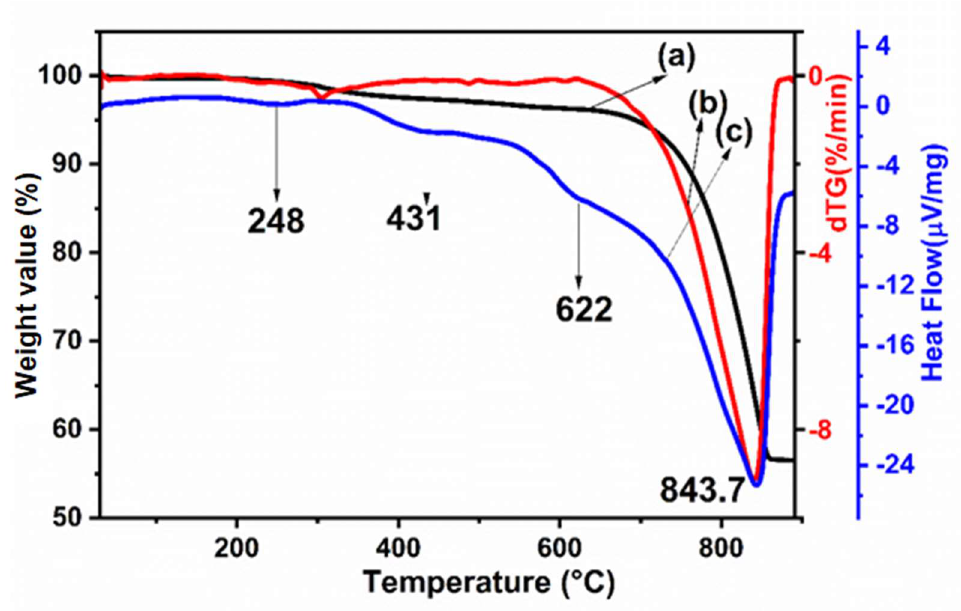
Figure 3. ( a ) TG, ( b ) DTG and ( c ) DTA curves under air flow for the GRS shell. Catalysts 2020 , 10 , x FOR PEER REVIEW 6 of 19